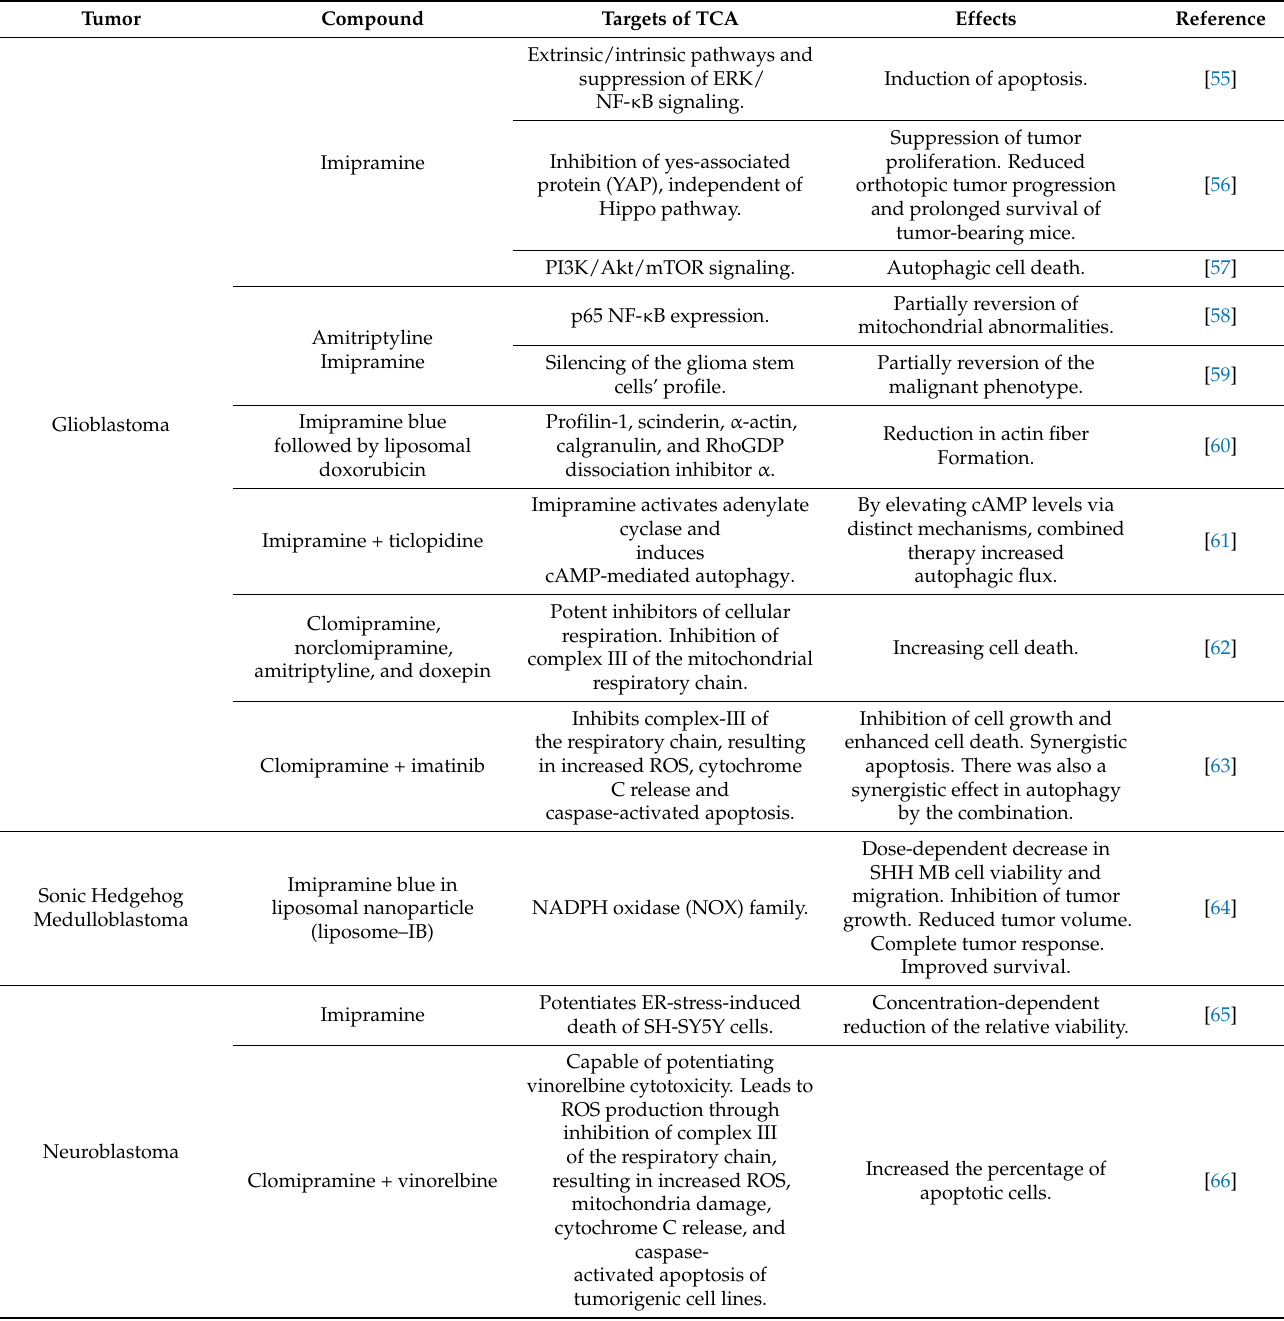
Table 2. Relevant in vitro and preclinical evidence of antitumoral properties of tricyclic